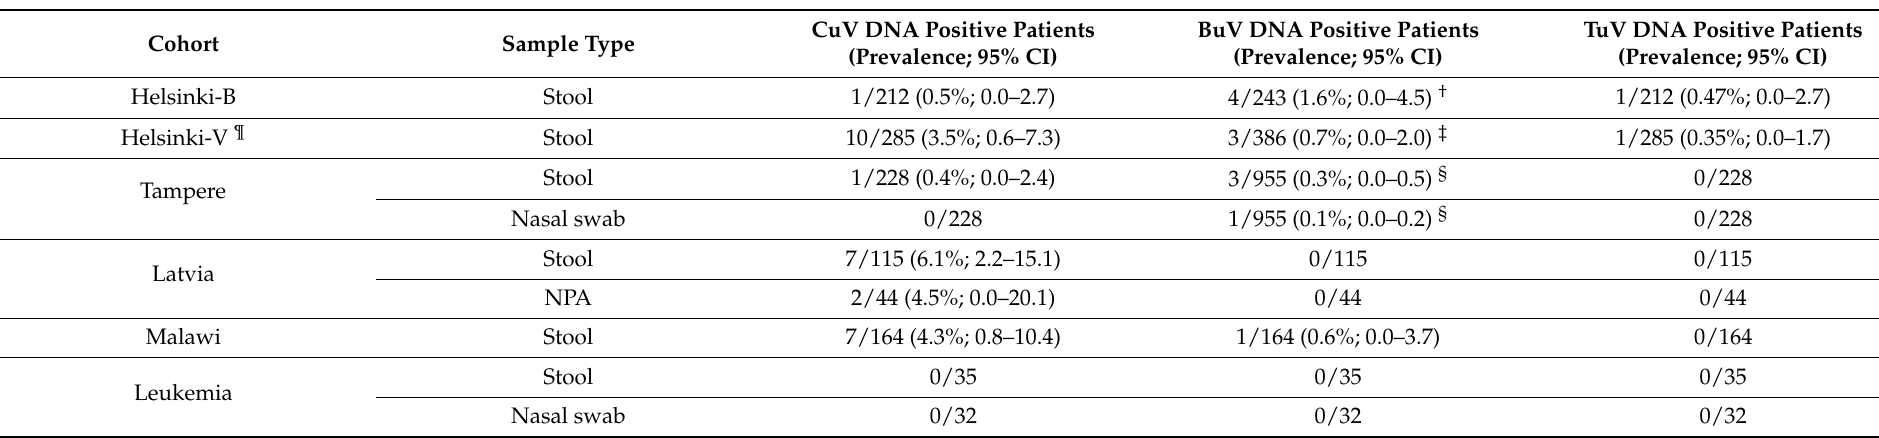
Table 2. Prevalence of CuV, BuV and TuV DNA in stool and respiratory samples in different population